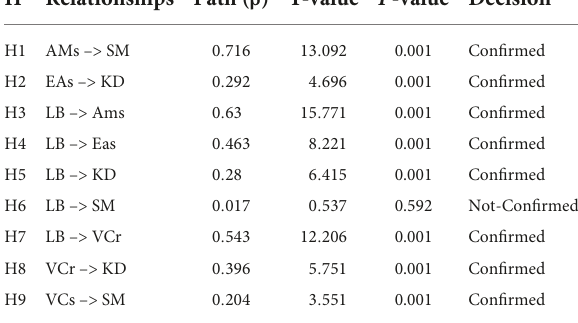
TABLE 4 Model fit summary. TABLE 5 Path, T-value, and P -value.